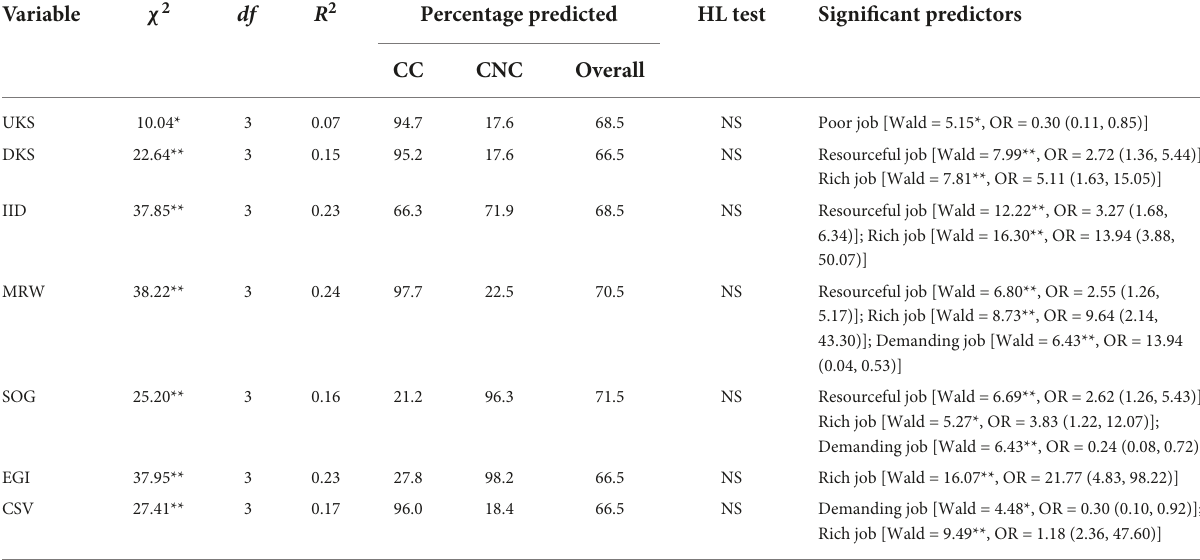
TABLE 5 Binary logistic regression analyses with job demands-resources profiles as independent variables and capabilities as dependent variables.